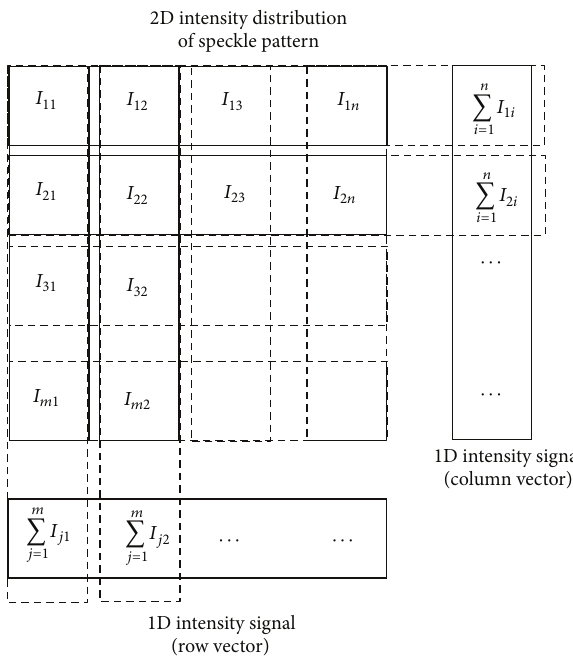
Figure 2: The principle of numerical processing of 2D speckle pattern to acquire 1D intensity signal for successive 1D numerical